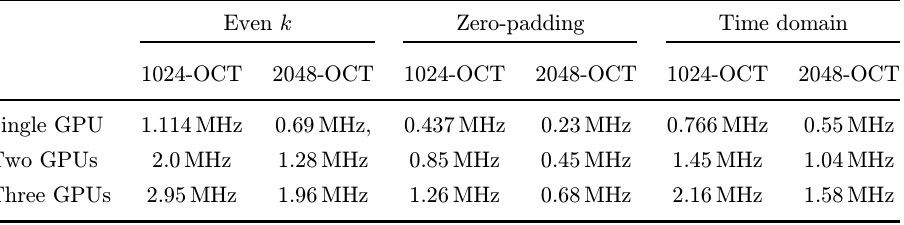
Fig. 4. Computing capability of two GPUs and three GPUs. Table 2. Computing capability of multi-GPU systems.